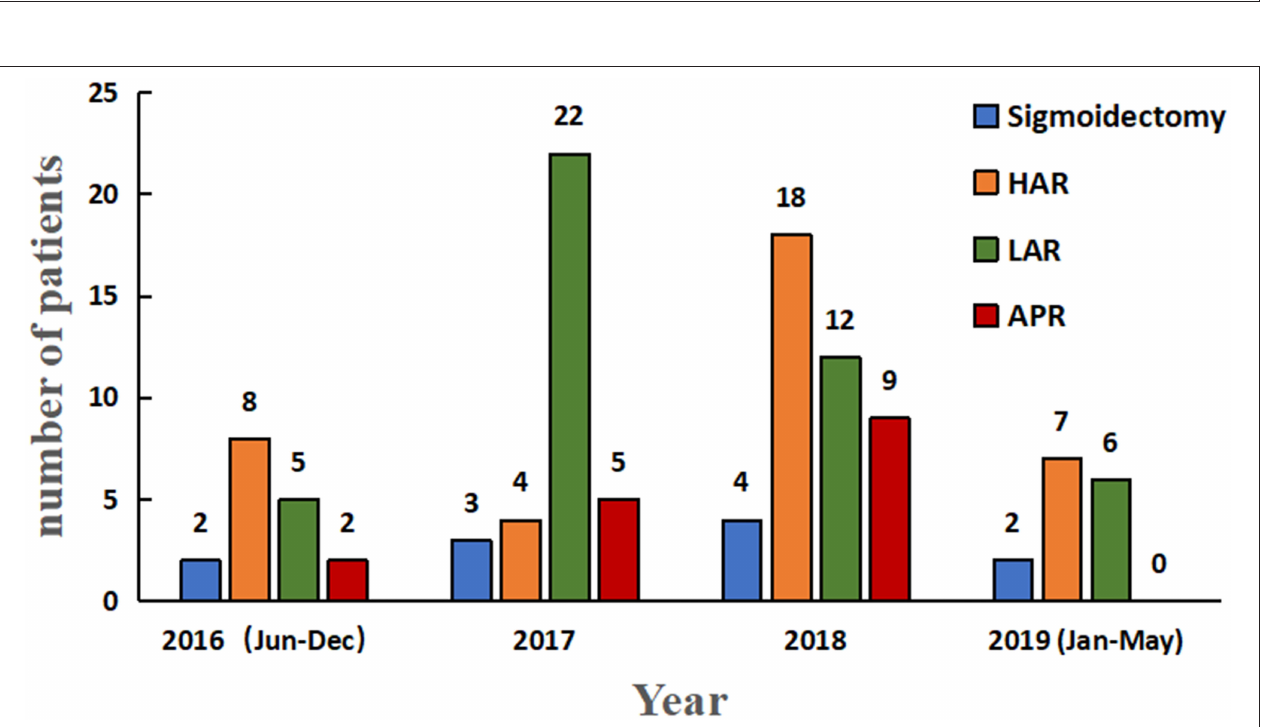
FIGURE 2 | Histogram depicting year-wise distribution of robotic sigmoidectomy. HAR, high anterior resection; LAR, low anterior resection; APR, abdominoperineal resection for colorectal cancer.